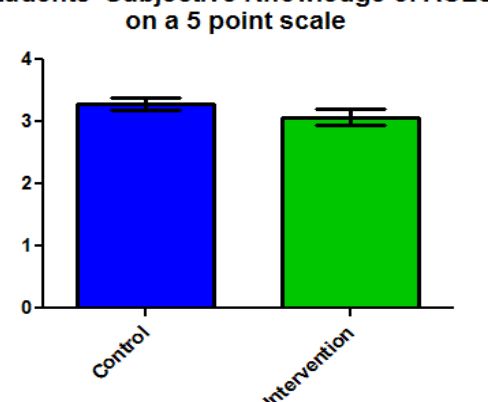
Figure 4. Students with access to computer based simulation did not assess their knowledge of ACLS guidelines differently than those without access.